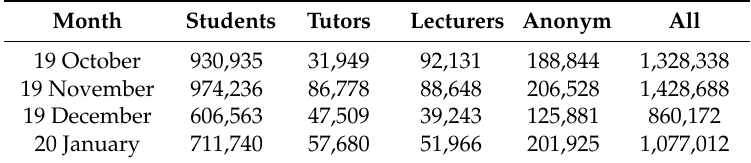
Table 2. Log-ins into the learning management system in winter semester 2019 / 2020. Source: Graz University of Technology, Educational Technology. Note: “anonym” are activities from people who are not logged in and navigate within courses with open access; “all” is not the sum, as some users have more than one role (e.g. a student who is also a tutor).